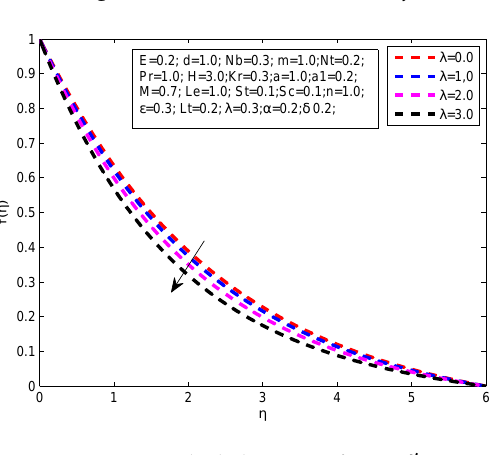
Figure 6. The behaviour of H on f (cid:48) .